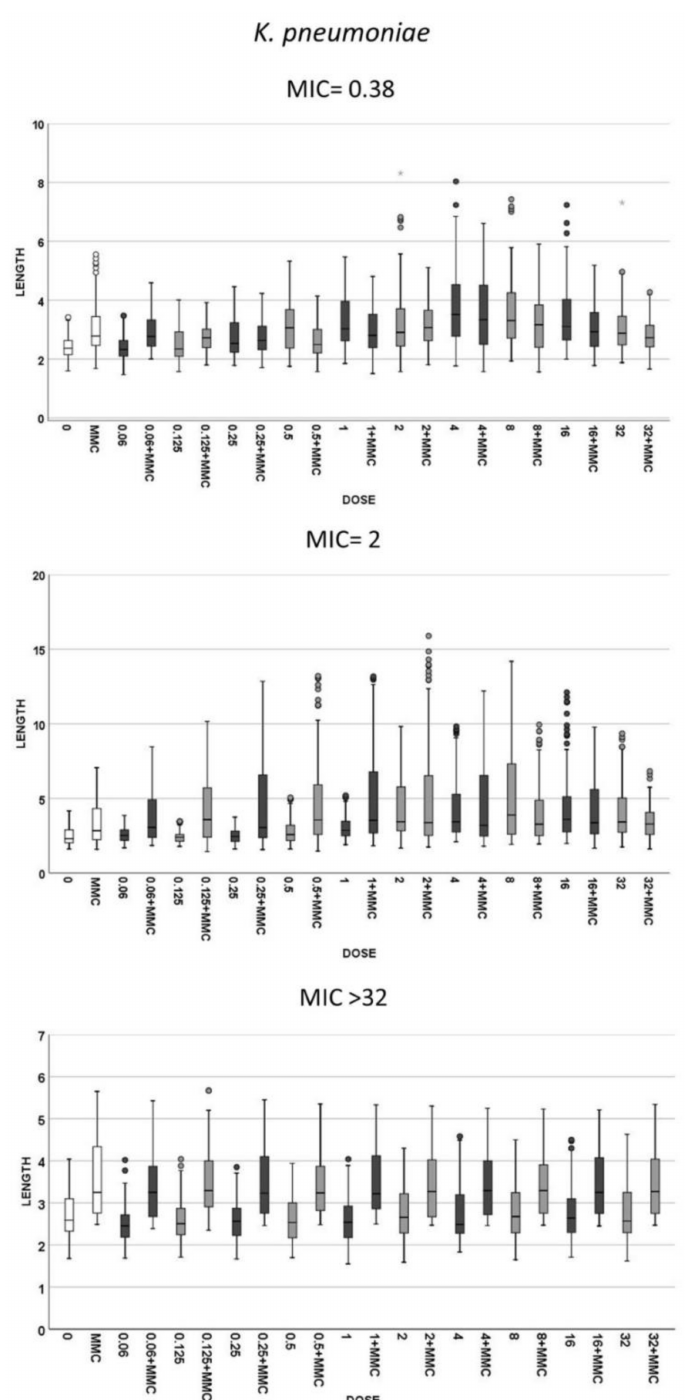
Figure 4. Cell length measures ( µ m) in the same strains of K. pneumoniae that were shown in Figure 2. The first image corresponds to a strain susceptible to cotrimoxazole, with MIC 0.38 mg/L, the second graphic is a strain with MIC 2 mg/L and third image is a resistant strain with MIC ≥ 32 mg/L. Each strain shows the cell length (vertical axis) in, from left to right (horizontal axis), control cultures (0), cultures incubated with 0.5-mg/L mitomycin C (MMC) and cultures incubated with increasing doses of cotrimoxazole alone, each paired with incubation of cotrimoxazole together with 0.5-mg/L